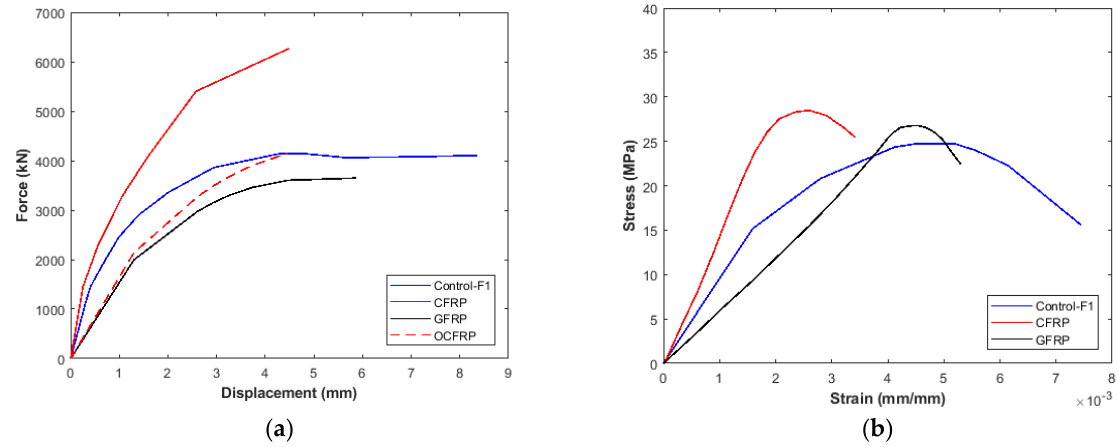
Figure 12. Group F ( a ) Load-Displacement diagram ( b ) Stress-Strain Diagram.